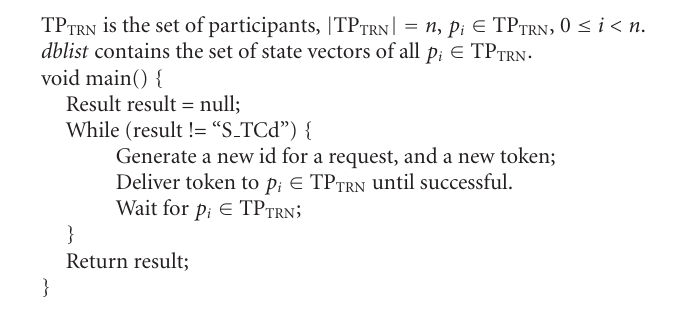
Algorithm 3: Behavior of p c